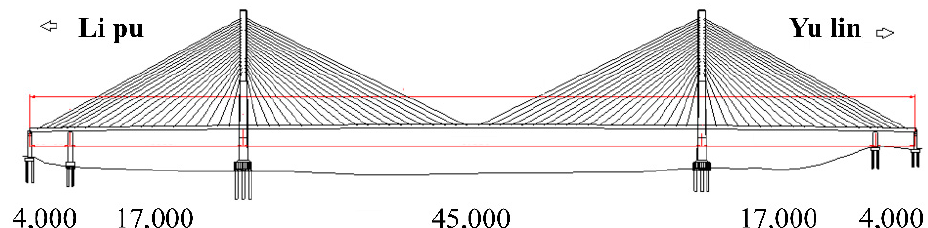
Figure 13. Schematic diagram of cable surface of Xiangsizhou Bridge.